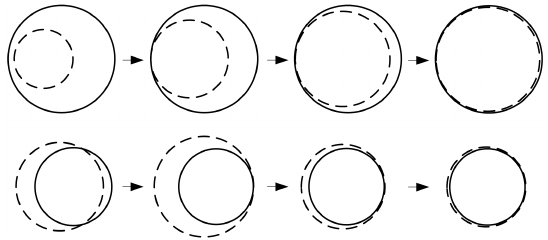
Figure 9. Circle Approximation Method: Each row shows an example of circle fitting process. The solid circles are to be detected and the dash circles are regulated to match the solid ones. Circle center, radius and rotation angle step are three initial inputs of this method. The center and radius can be approximated only asking the drawn and the target circles have some common